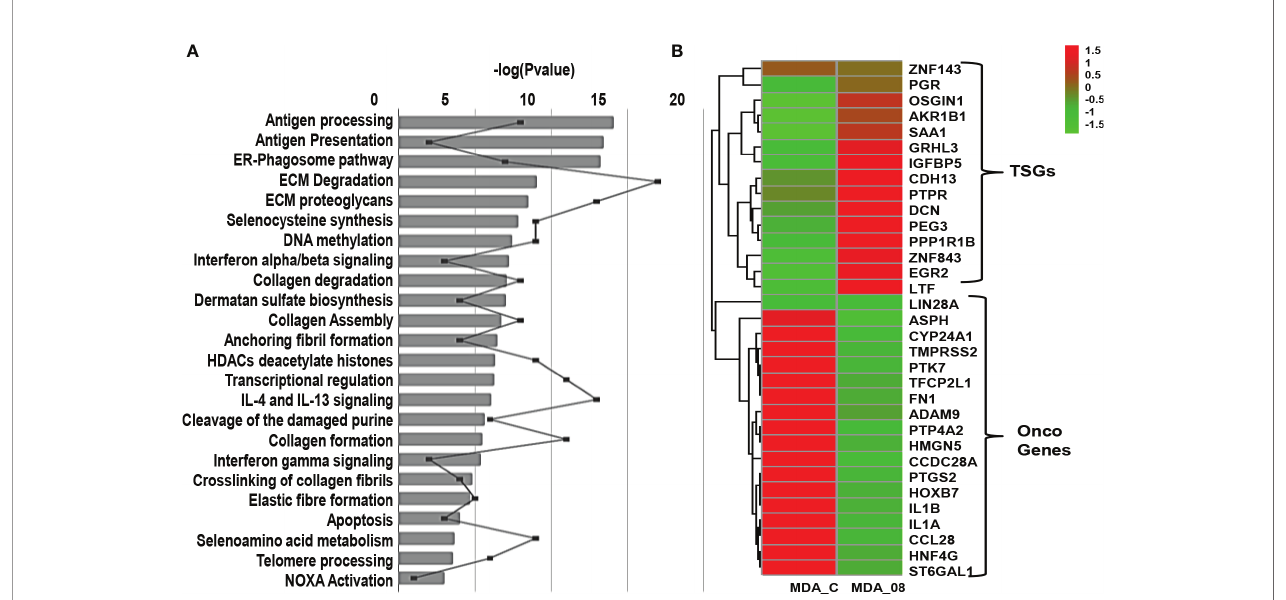
FIGURE 5 | Transcriptome pro fi le of breast cancer cells upon ST08 treatment: (A) Pathways regulated in MDA-MB-231 TNBC cells upon ST08 treatment. (B) Heatmap of DE tumor suppressor and oncogenes genes in MDA-MB-231upon ST08